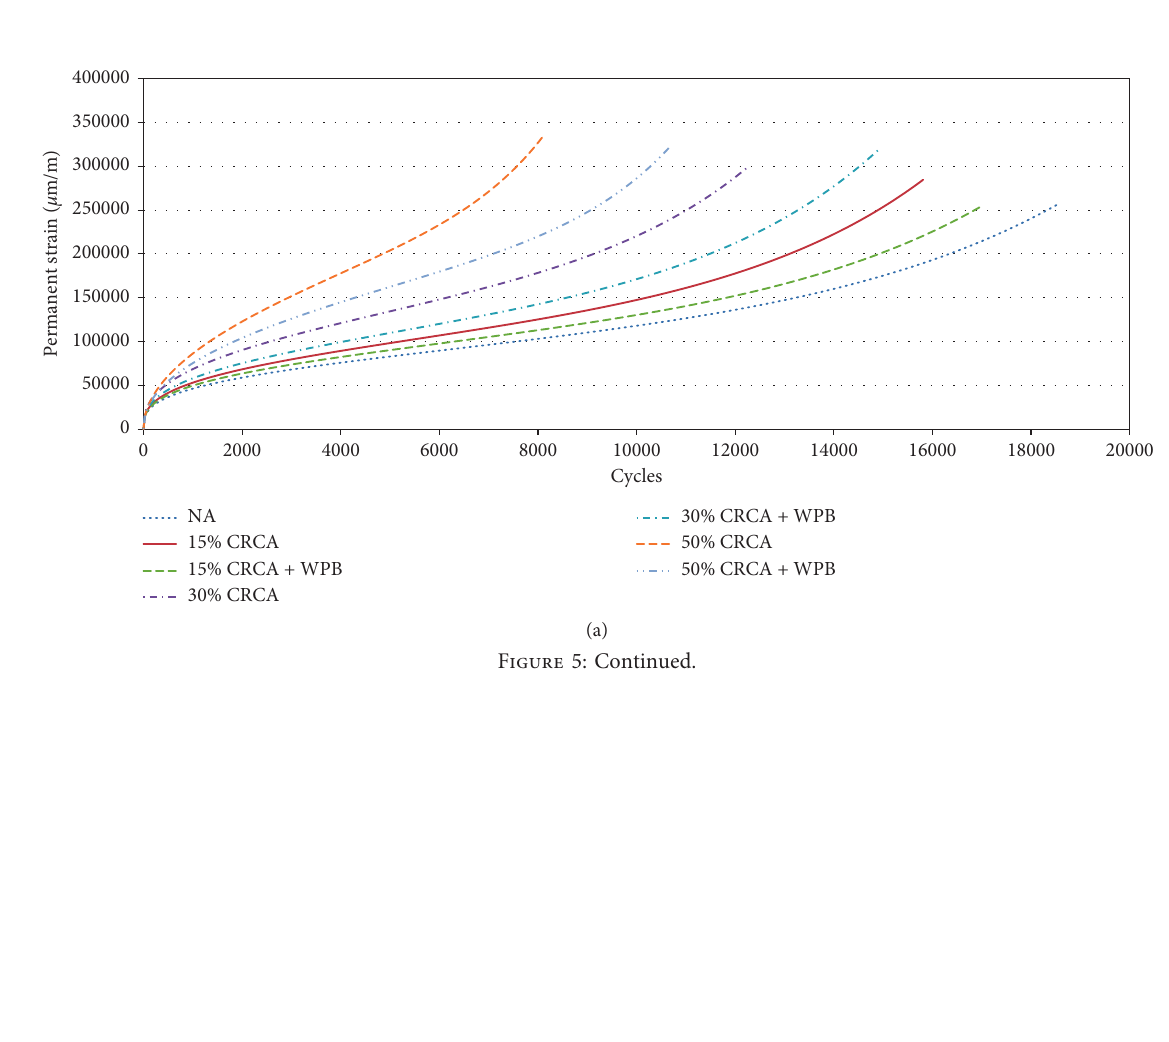
Figure 4: Stiffness modulus test results for different mixes at two temperatures.